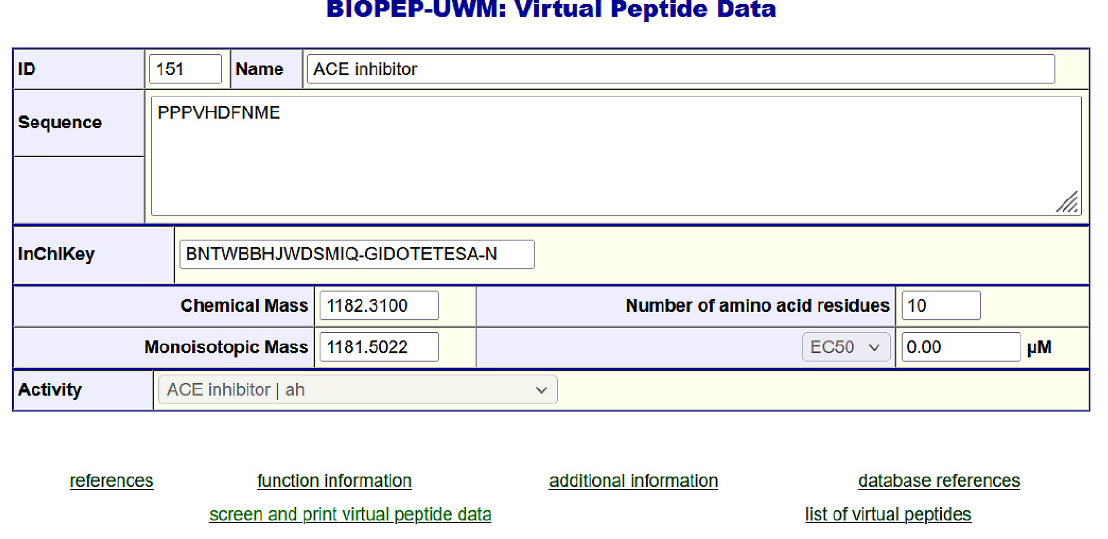
Figure 4. Screenshot of example peptide data: a predicted inhibitor of the angiotensin-converting enzyme (ACE) (BIOPEP-UWM Virtual ID: 151). The above peptide has been described by Wenhui et al. [16].